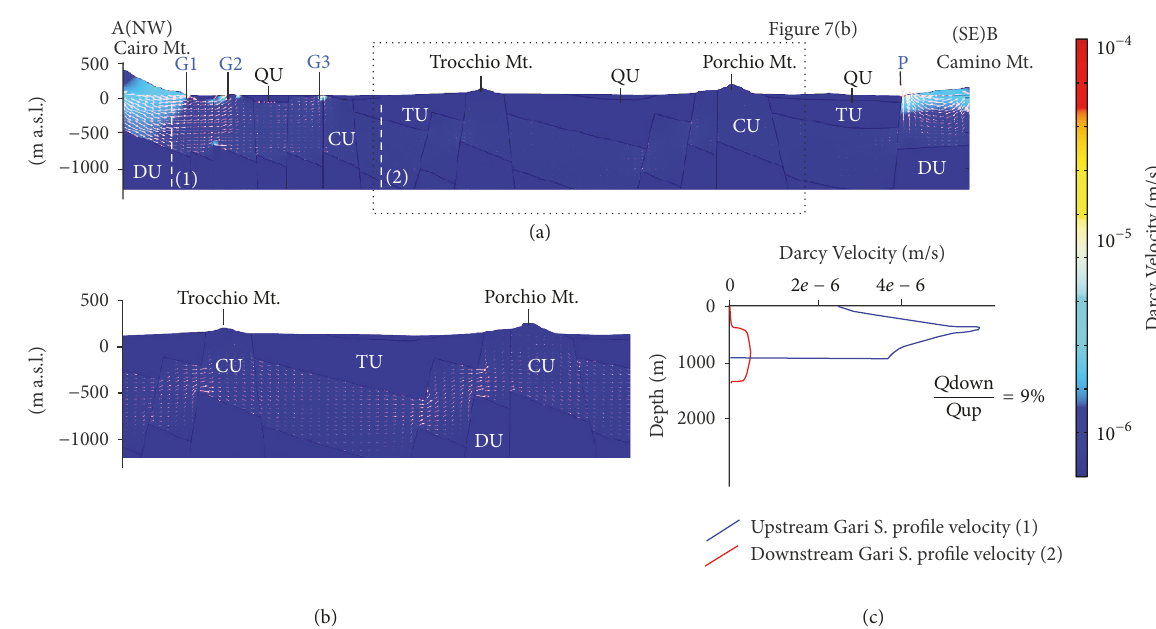
Figure 7: Numerical analysis of the Boni model [4, 37] (section in Figure 4). Key to the legend: Quaternary unit (QU); terrigenous unit (TU); limestone unit (CU); dolostone unit (DU). Cassino urban Springs G1 (elevation of 41 m a.s.l.); Terme Varroniane Springs G2 (elevation of 32-33 m a.s.l.): Borgo Mastronardi Springs G3 (elevation of 31-30m a.s.l.); Peccia Spring P (elevation of 25 m a.s.l.). Seepage verifies the Boni model from Cairo Mt. to Gari Spring (G1, G2, and G3) and from Camino Mt. (Venafro Mts.) to Peccia spring (P); (b) in the central sector, seepage from Gari to Peccia Springs is simulated; (c) the upstream and downstream groundwater velocity profile from Gari to Peccia Spring. The downstream/upstream discharge ratio is around 9%, calibrated under the best assumptions, and is not sufficient to justify the Boni conceptual model [4,